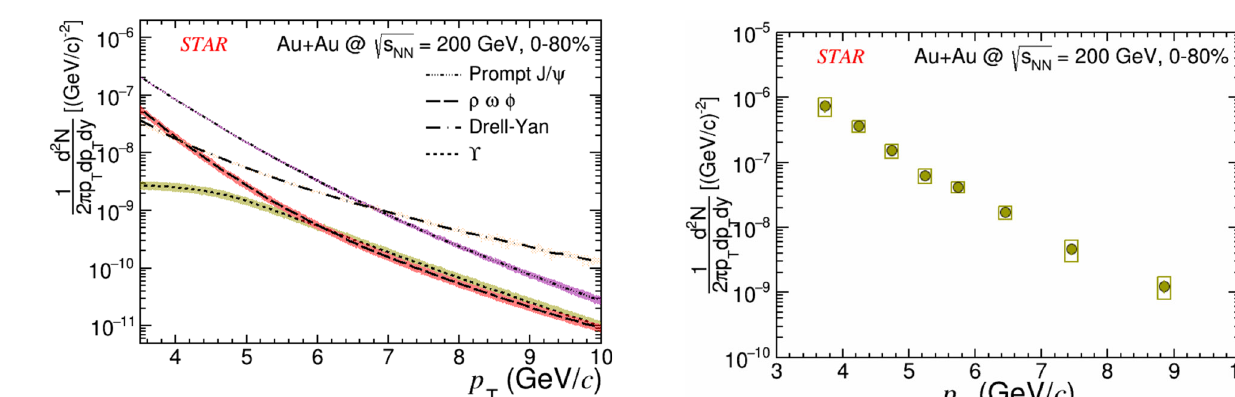
which are calculated using the embedding technique.